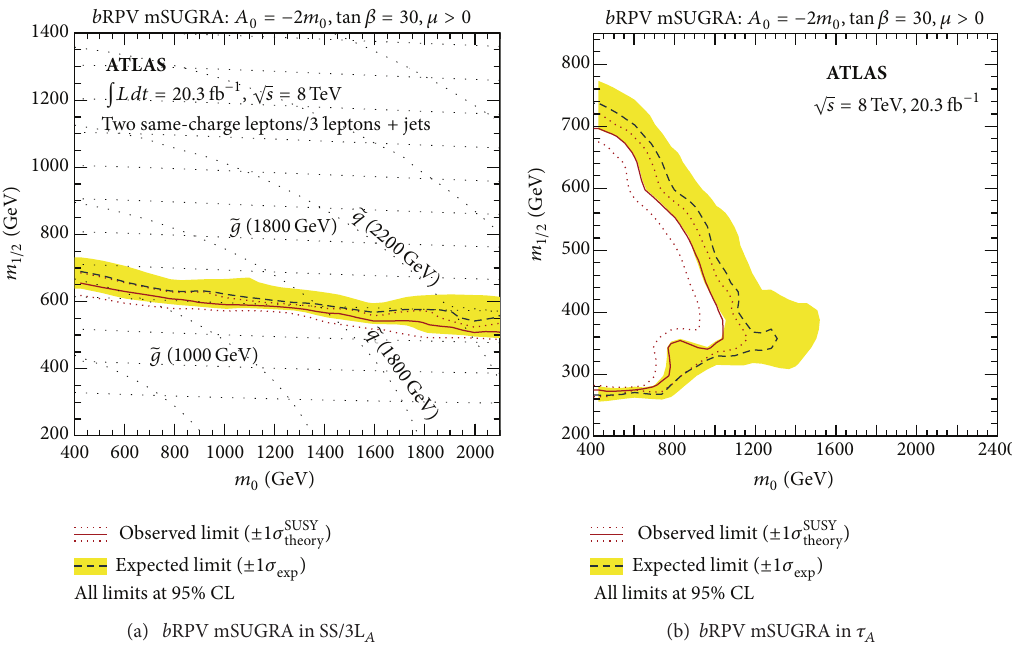
Figure 2: Observed and expected exclusion limits for the b RPV mSUGRA model obtained in the SS/3L ATLAS analysis (left, from [38]) and in the 𝜏 𝐴 analysis (right, from [39]).